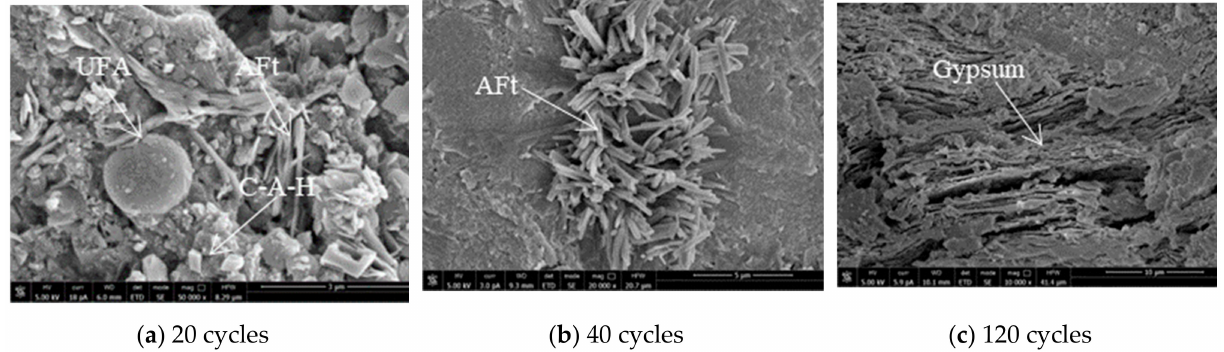
Figure 17. SEM photo of Na 2 SO 4 solution erosion of M10F30 concrete.